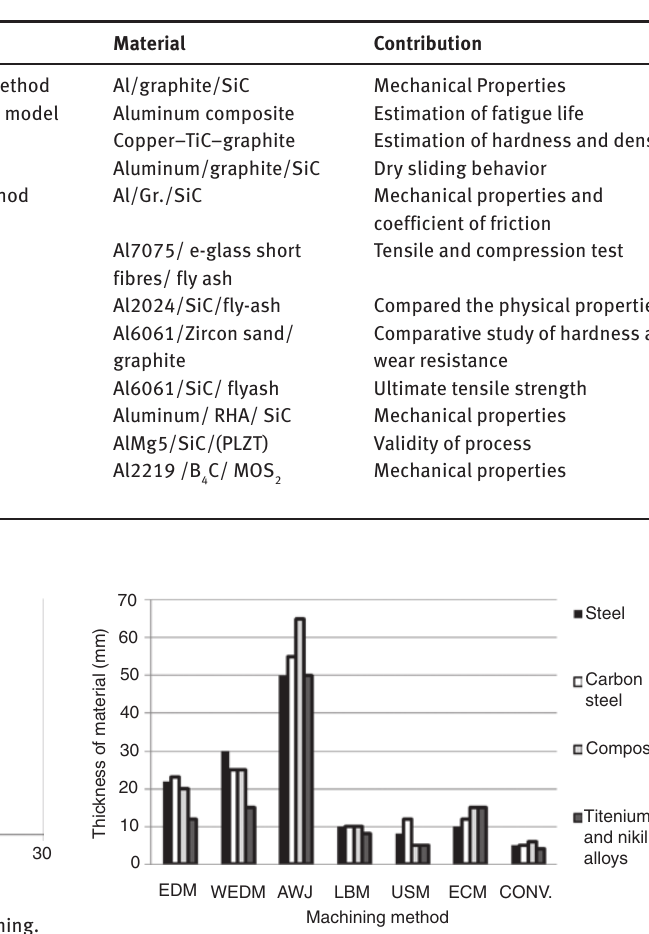
Table 3: Evaluation of hybrid metal matrix composite.